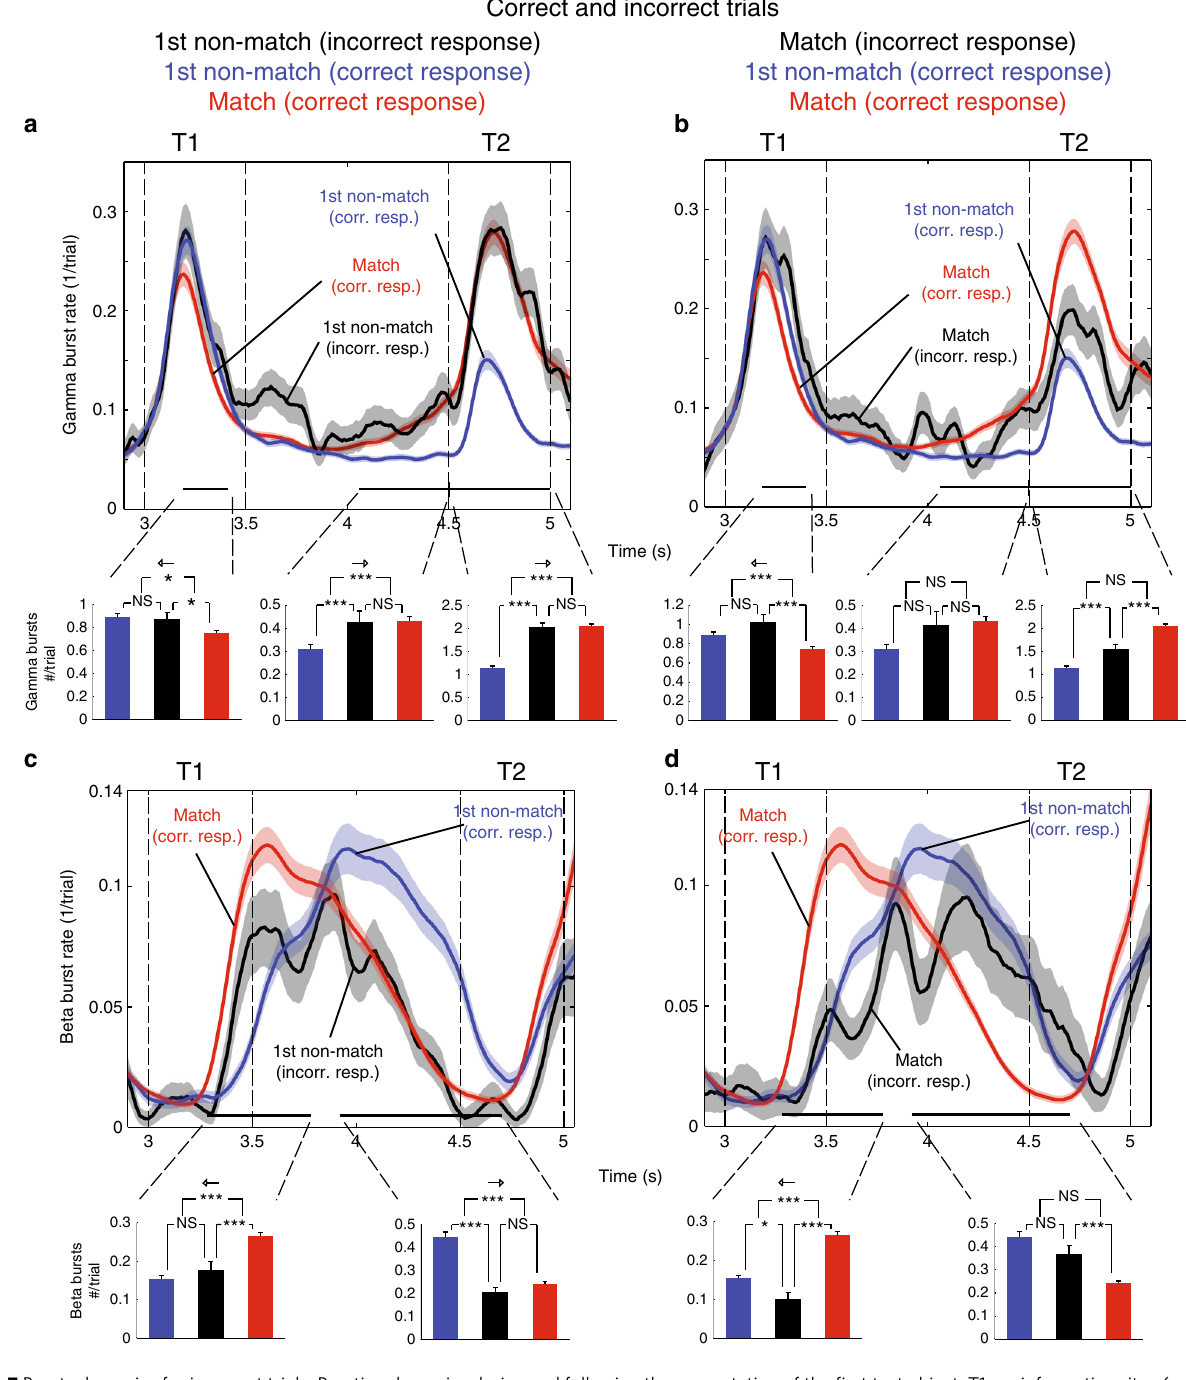
Fig. 7 Bursts dynamics for incorrect trials. Bursting dynamics during and following the presentation of the fi rst test object, T1, on informative sites ( n = 130). The corresponding burst rates for the correct matching (red) and correct fi rst test non-matching, i.e., T1 ≠ S1 (blue) conditions are given as reference. Black curves illustrate burst rates for incorrect trials in the matching (right panel column) and fi rst test non-matching (left panel column) conditions. Black horizontal lines at the bottom of each panel denote intervals when the burst rates in the correct matching and correct non-matching conditions are signi fi cantly different ( p < 0.05; cluster-based permutation test). The bar plots below represent the average number of bursts per trial and recording site for the three conditions in the corresponding panel within the aforementioned intervals. Planned pair-wise comparisons between these mean statistics (the incorrect condition was compared to the two correct conditions) were conducted using two-sided permutation tests. In addition, we tested the hypothesis that burst counts on incorrect trials were equidistant (Methods section) to the two correct conditions (arrow indicate which condition the error trials were more similar to for signi fi cant effects). a , b Show gamma burst rates, and c , d show beta burst rates. For correct trials: n = 130 (number of electrodes), whereas for the incorrect matching trials: n = 117 (as some sessions were devoid of error trials of this kind) and for the incorrect non-matching trials: n = 118. Error bars/shading correspond to